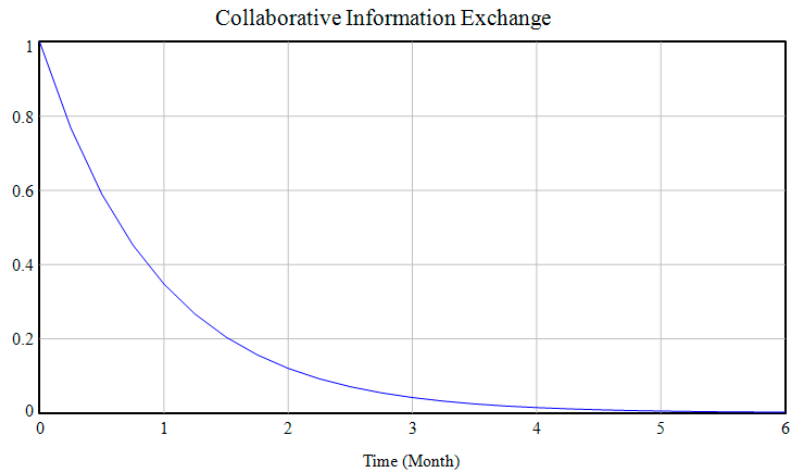
Figure 15. Simulation result of ‘collaborative information exchange’.